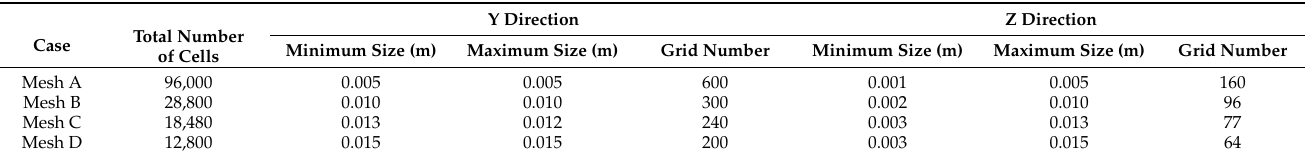
Table 2. Cases for mesh sensitivity analysis.